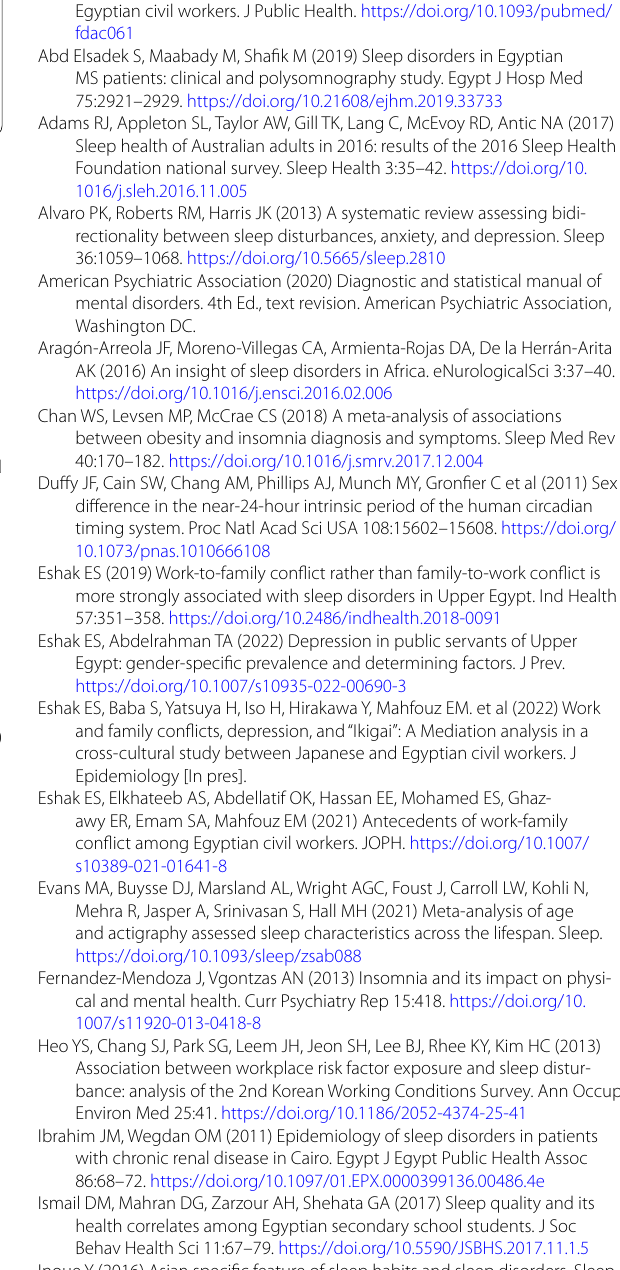
Table 2. Stepwise multiple linear regression for factors predicting the JSEQ score of each sleep disorder among Egyptian female public offi- cials. Table 3. Stepwise multiple linear regression for factors predicting the JSEQ score of each sleep disorder among Egyptian male public